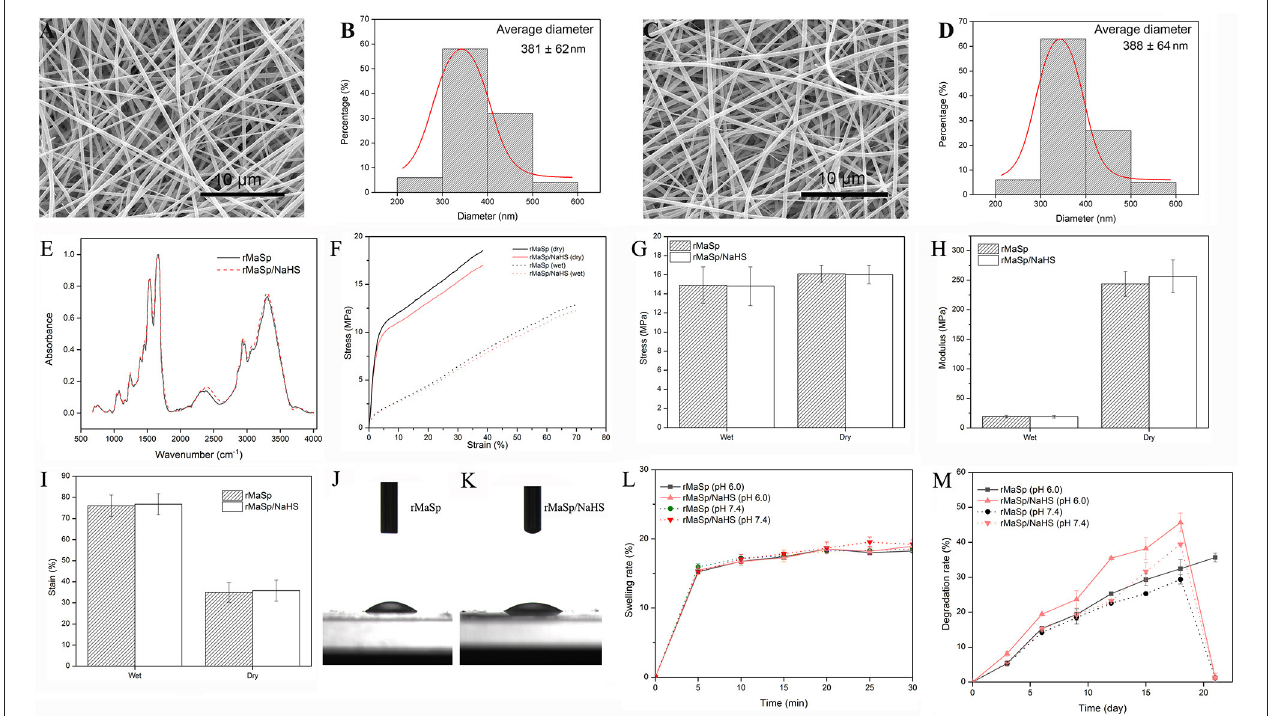
FIGURE 2 | Characterization of nanofibrous membrane. The SEM images of rMaSp (A) and rMaSp/NaHS membrane (C) and diameter distribution of rMaSp (B) and rMaSp/NaHS nanofibers (D) . The Fourier transform infrared spectroscopy spectrum of dried rMaSp membrane and rMaSp/NaHS membrane (E) . The mechanical properties of dry and wet rMaSp/NaHS membrane (F–I) . The water droplets on the rMaSp (J) or rMaSp/NaHS membrane surfaces (K) . The swelling capacity of rMaSp or rMaSp/NaHS membrane (L) . The degradation profile of rMaSp or rMaSp/NaHS membrane (M) .